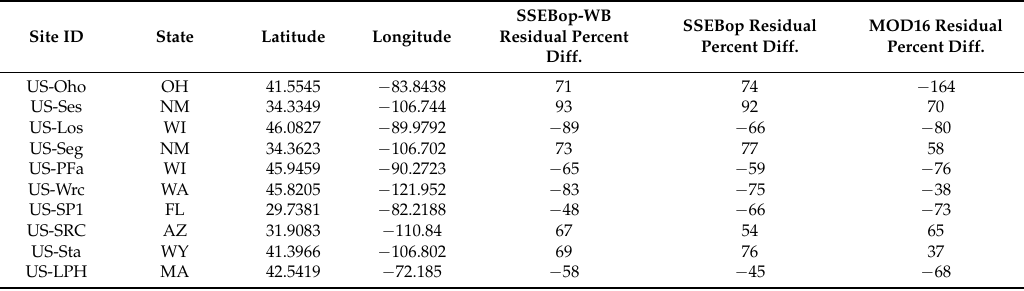
Table 5. AmeriFlux sites with the highest average percent difference compared with remote sensing ET data sets, listed in descending order for the new SSEBop-WB data set, the SSEBop ET, and the MOD16